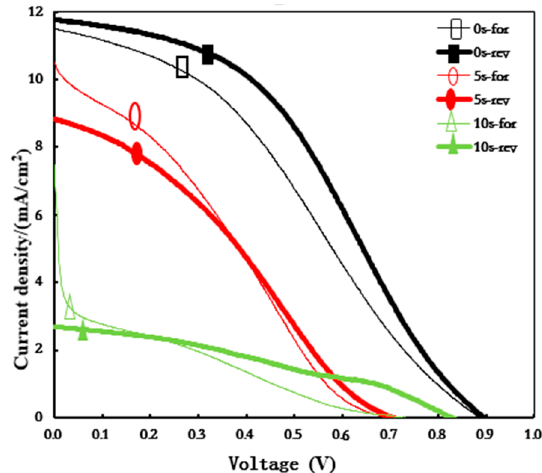
Figure 6. The density–voltage (J–V) curves from reverse scan (rev) and forward scan (for) of the perovskite solar cells (PSCs) devices based on the different delay times, measured under simulated sunlight with an intensity of 100 mW/cm 2 (air-mass (AM) 1.5 G) .